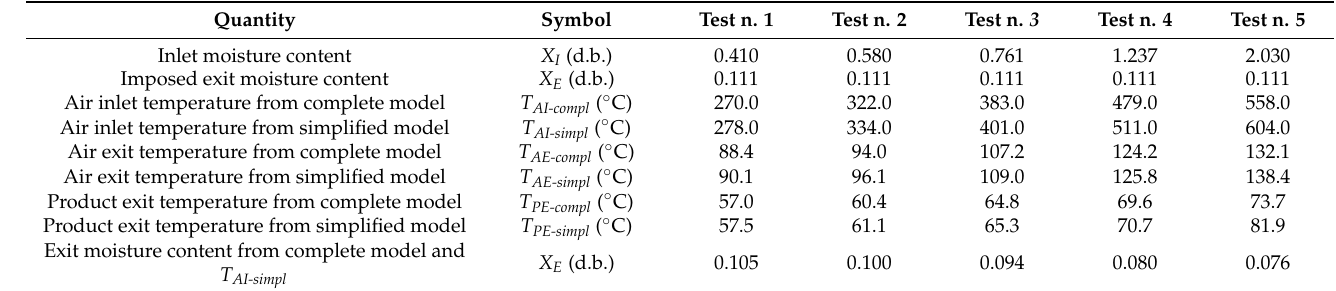
Table 5. Comparison between the air and product temperatures simulated with the complete math- ematical model and the simplified one. The goal is to control the dryer, through the air inlet temperature value, to keep the product exit moisture content X E constant (at 0.111). The last line shows the exit moisture content calculated with the complete model after having implemented the air inlet temperatures simulated using the simplified